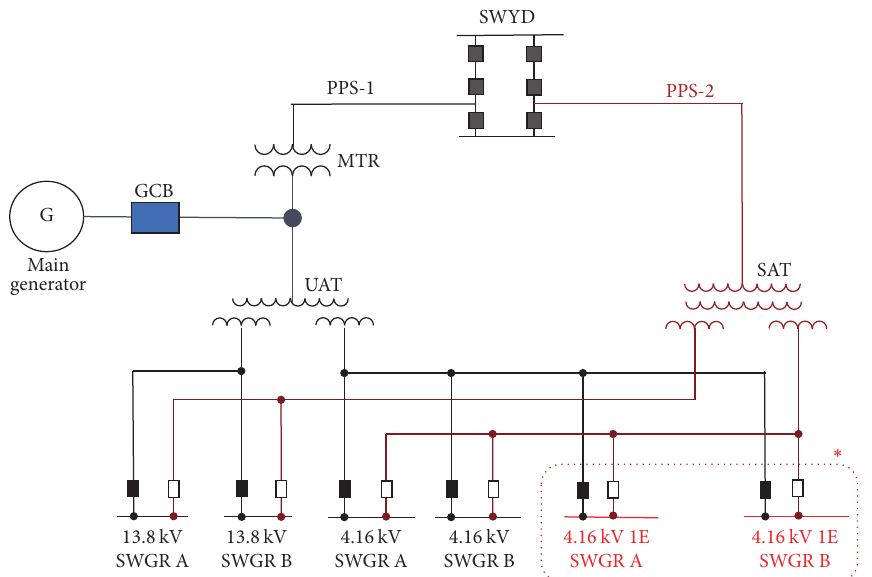
Figure 1: The existing electric power system of APR1400. ∗ This dotted line represents the boundary of Class 1E system. Otherwise, out of the dotted line is represented non-Class 1E